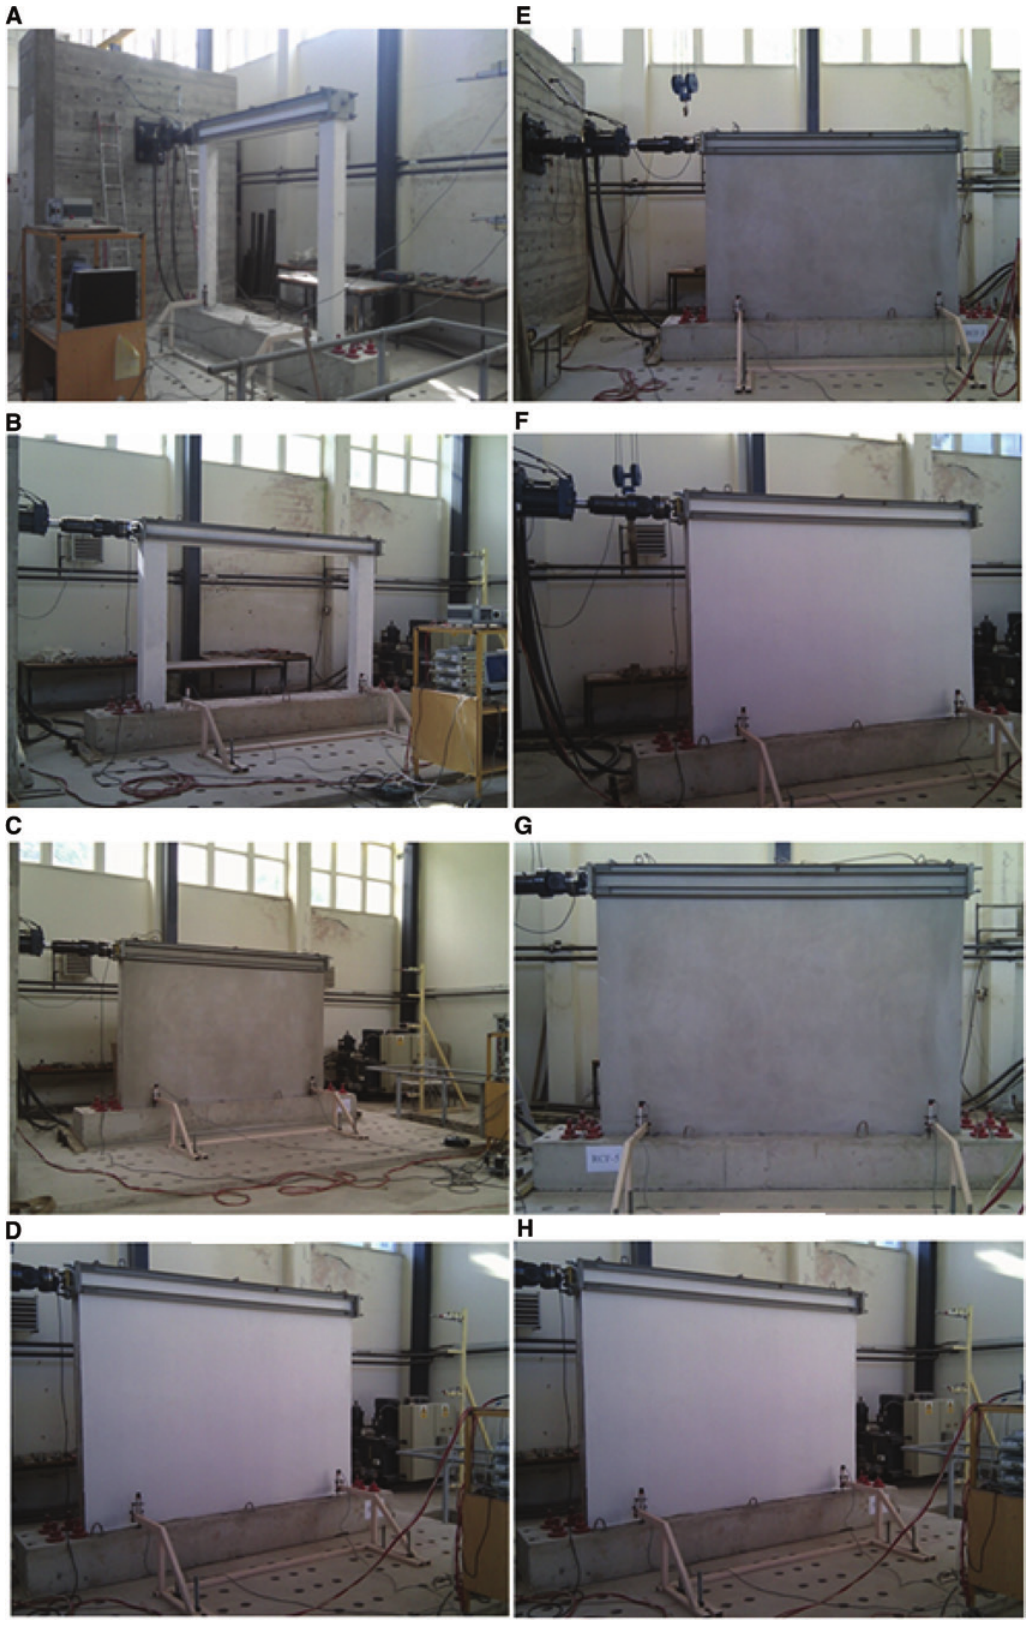
Figure 6: General views of test frames under lateral reversed cyclic loading. (A) PRCF-1, (B) PRCF-2, (C) RCF-1, (D) RCF-2, (E) RCF-3, (F) RCF-4, (G) RCF-5, (H)